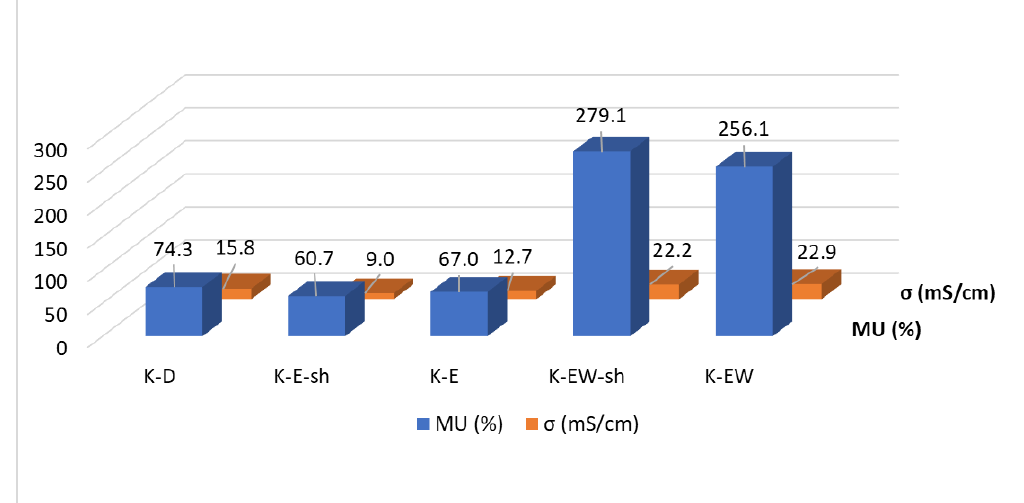
Figure 4. Comparison of SPEEK membranes realized with different solvents and casting